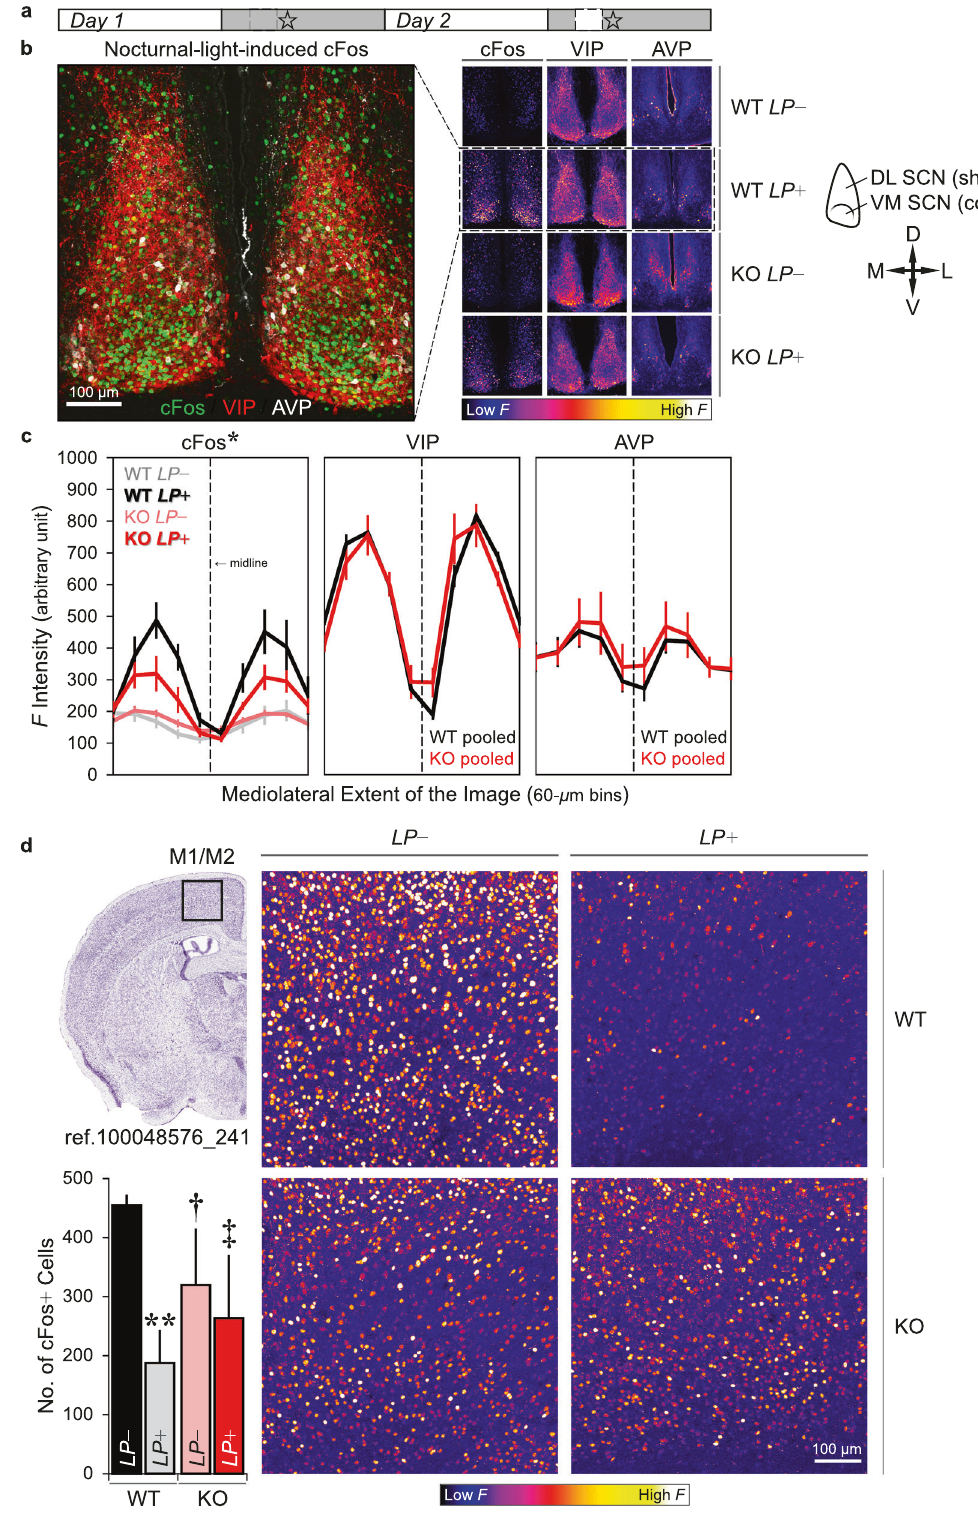
more active in terms of odour exploration (expressed in seconds min − 1 ) and distance travelled (expressed in metres min − 1 ) during the sample phase ― similar to that reported in our